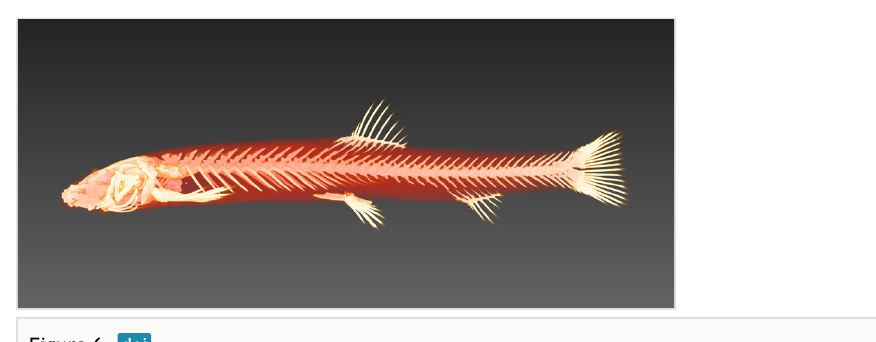
Figure 5. A 3D skeletal model of a paratype of Cobitis striata fuchigamii (MPM-Fi1501).